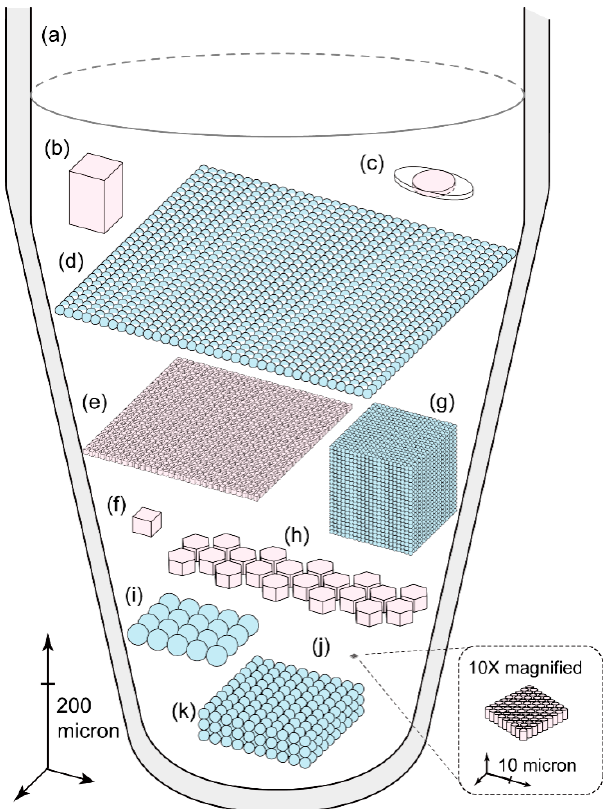
Figure 1. An overview of representative digital PCR approaches. For each partition shown herein represents approximately 1000 partitions in the corresponding methods. Their sizes too roughly reflect those in real-world situations. Micro-chambers in microfluidic chips are shown in pink and emulsion droplets in light blue. ( a ) Digital PCR in well plates [3,4]; ( b ) The first microfluidic chip for digital PCR in 2006 [5]; ( c ) SlipChip in 2010 [6]; ( d ) One-million droplet array in 2011 [7]; ( e ) Megapixel digital PCR in 2011 [8]; ( f ) Digital Array IFC (type: qdPCR 37k) from Fluidigm’s Biomark HD (Fluidigm Corporation, South San Francisco, CA, USA); ( g ) RainDrop digital PCR from Raindance Technologies (Lexington, MA, USA); ( h ) QuantStudio 3D from Life Technologies (now Thermo Fisher, Waltham, MA, USA); ( i ) QX200 droplet digital PCR platform from Bio-Rad (Hercules, CA, USA); ( j ) The densest and smallest microwell-based microfluidic digital PCR to date in 2012 [9]; ( k ) Chip-free digital PCR in droplets generated via micro-channel array (MiCA) centrifugation in 2017 [10].